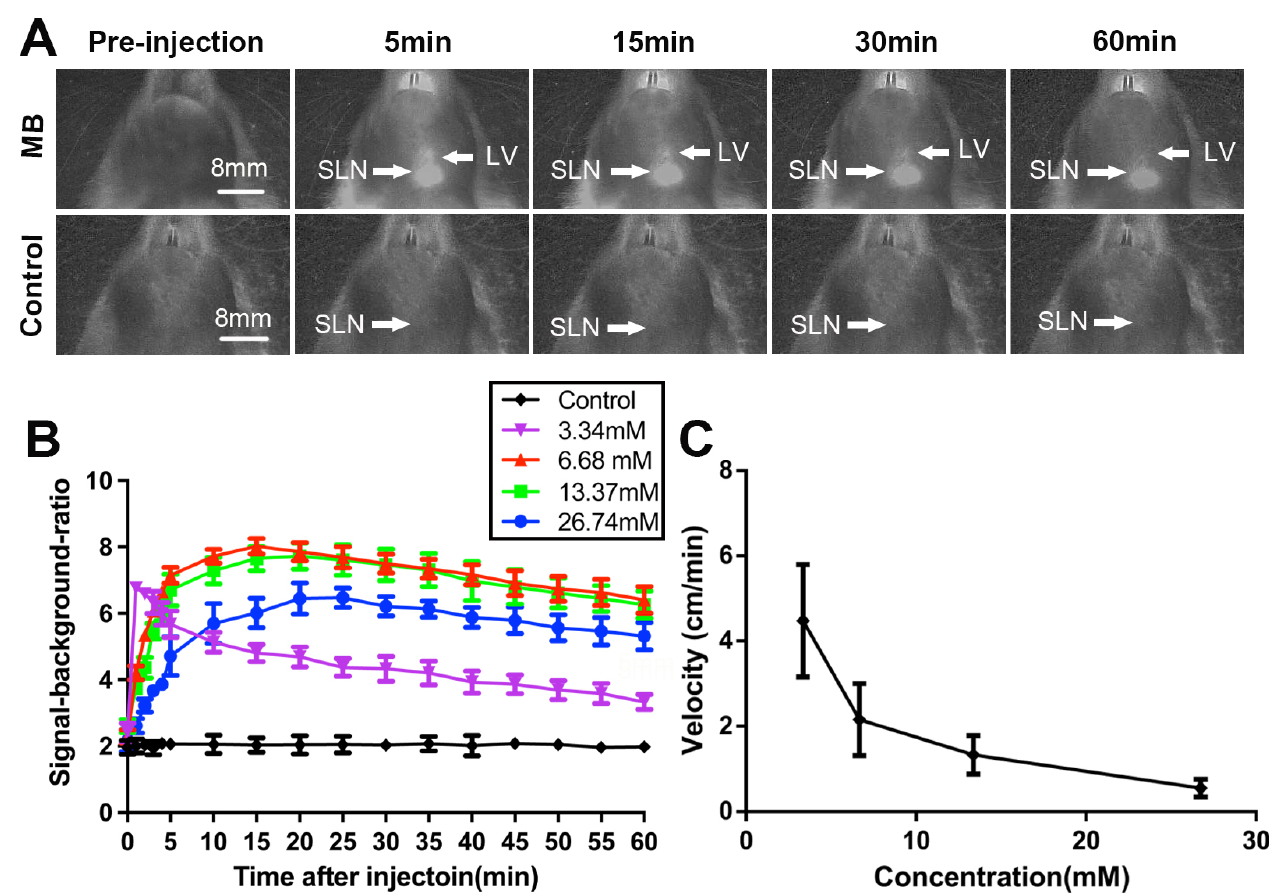
Figure 1. Sentinel lymph node mapping using MB NIR fluorescence imaging in rats. ( A ) Fluorescence images acquired before injection and 5, 15, 30, and 60 min after the injection of 6.68 mM MB and saline in rats. SLN = sentinel lymph node, LV = lymphatic vessel. ( B ) Changes in the SBR of the concentration groups (mean ± SD) within the SLN region over time after injection. Differences were observed between concentration groups ( p < 0.001). ( C ) The velocity of MB movement (mean ± SD) is plotted as a function of the MB concentration. The velocity of the MB movement significantly decreased with the increased MB concentration ( p < 0.001). Table 1. The initial and optimal imaging times required to observe SLN fluorescence in the concen- tration groups.